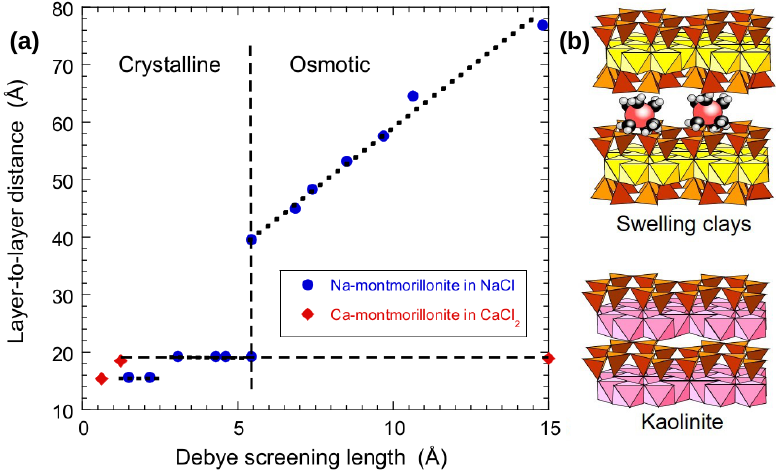
Figure 2. ( a ) X-ray diffraction measurements of the swelling of montmorillonite neutralized either by Na + (blue) or by Ca 2+ (red) counterions and dispersed, respectively, in NaCl or CaCl 2 aqueous solu- tions. The data are issue from Ref. [4]; ( b ) Structures of kaolinite and swelling clays (montmorillonite, laponite, saponite, beidellite, and